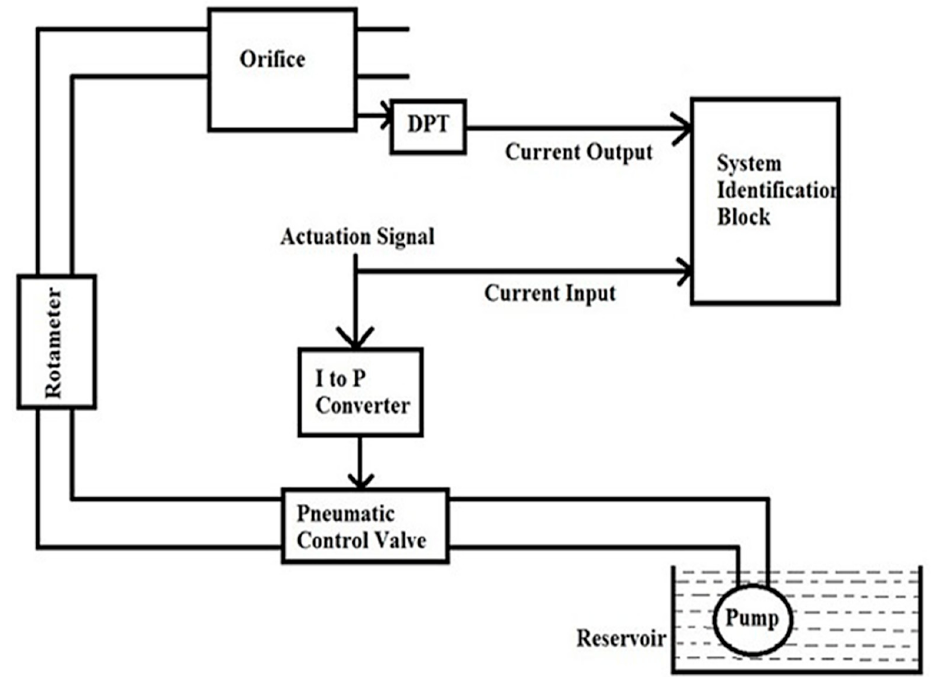
Figure 5. Block diagram of identification block.